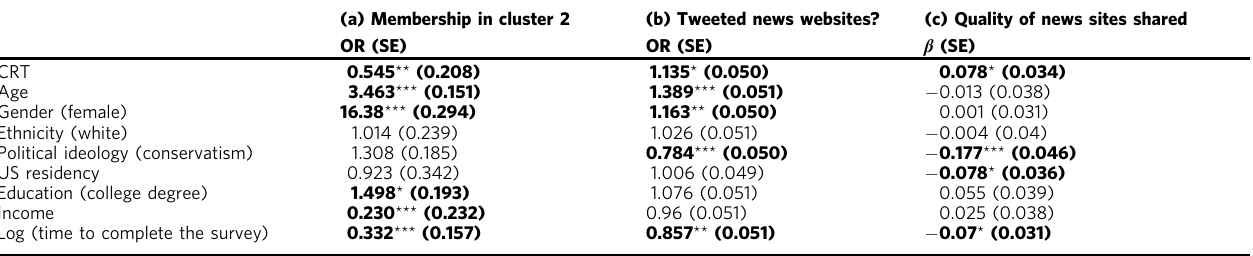
Table 3 Users ’ characteristics and clusters in co-followers ’ network, quality of content, and tweeting from news websites.